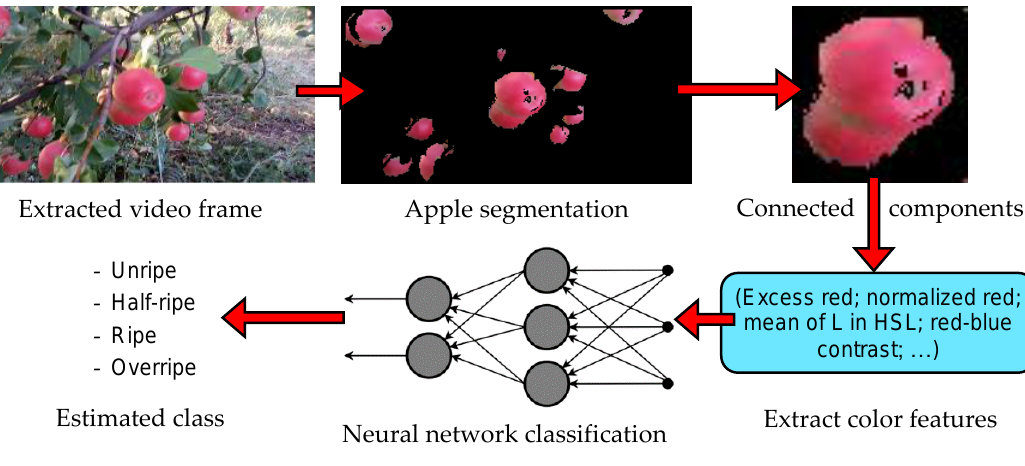
Figure 1. Scheme of the proposed algorithm for apple ripening estimation using color features.